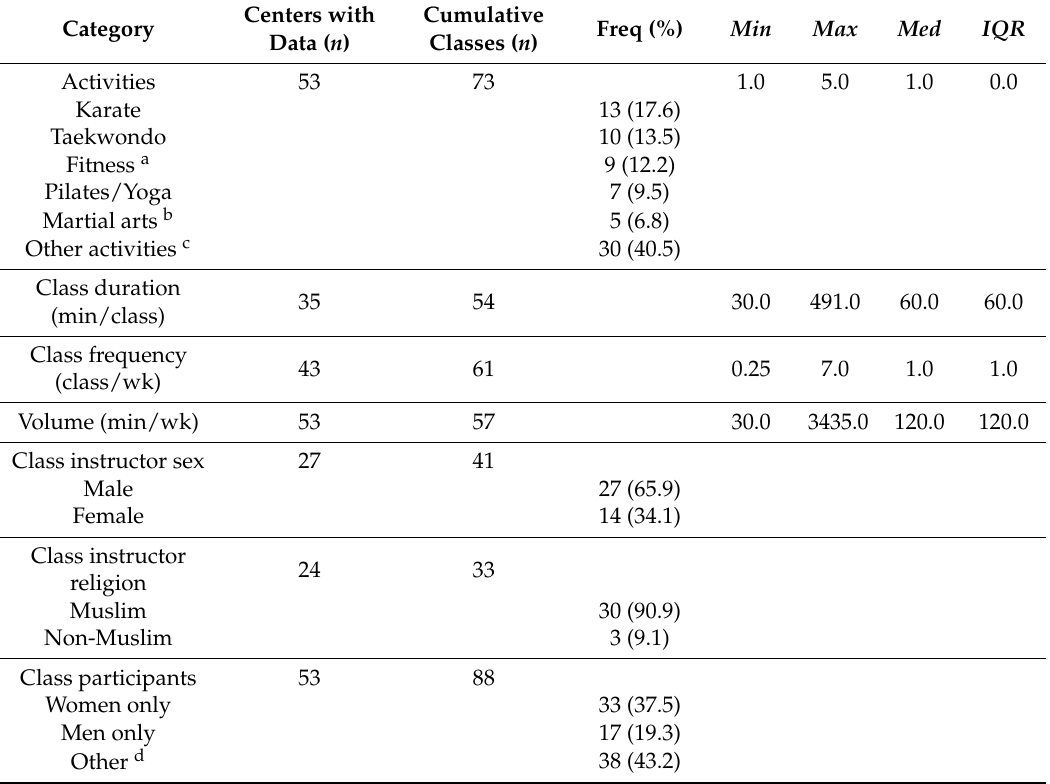
Table 2. Islamic center fitness class descriptive data ( n = 53